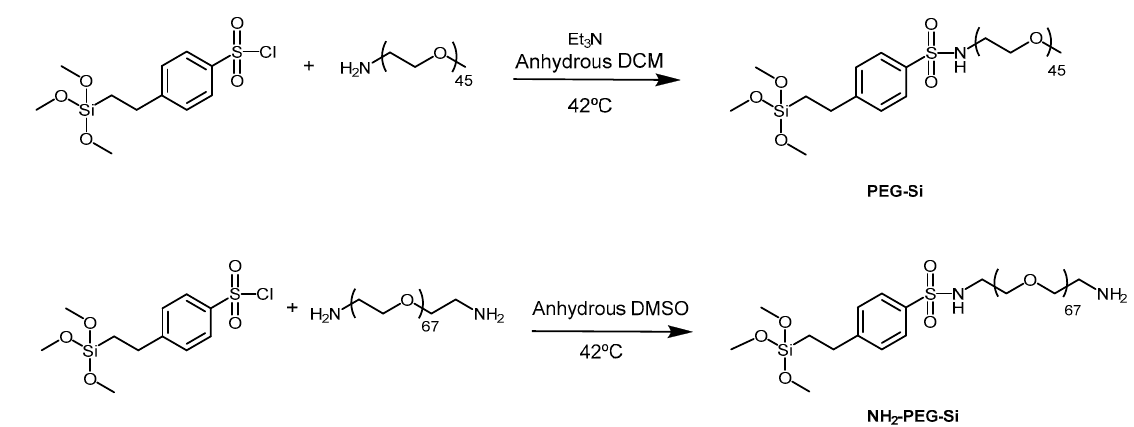
Figure 2. Synthesis of the PEGylated derivatives for nanoparticle coating. DCM = dichloromethane. DMSO = dimethylsulfoxide.